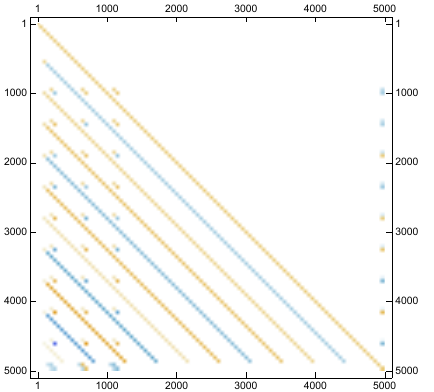
Figure 2. The sparsity pattern of the inverse matrix X = A − 1